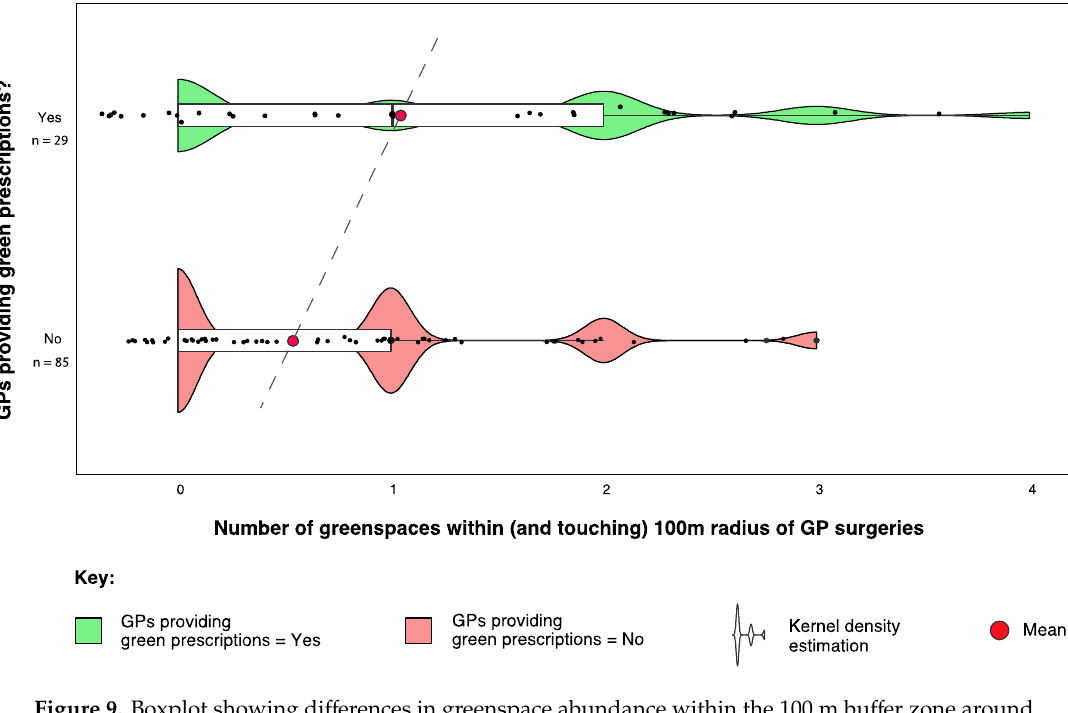
Figure 9. Boxplot showing differences in greenspace abundance within the 100 m buffer zone around GP surgeries that did (green) and did not (red) prescribe nature-based interventions. The maximum number within 100 m of any practice was n = 4. The violin plots show kernel density estimation, i.e., representing the distribution shape of the data and the points have a small amount of random variation (jitter) to reduce over-plotting.